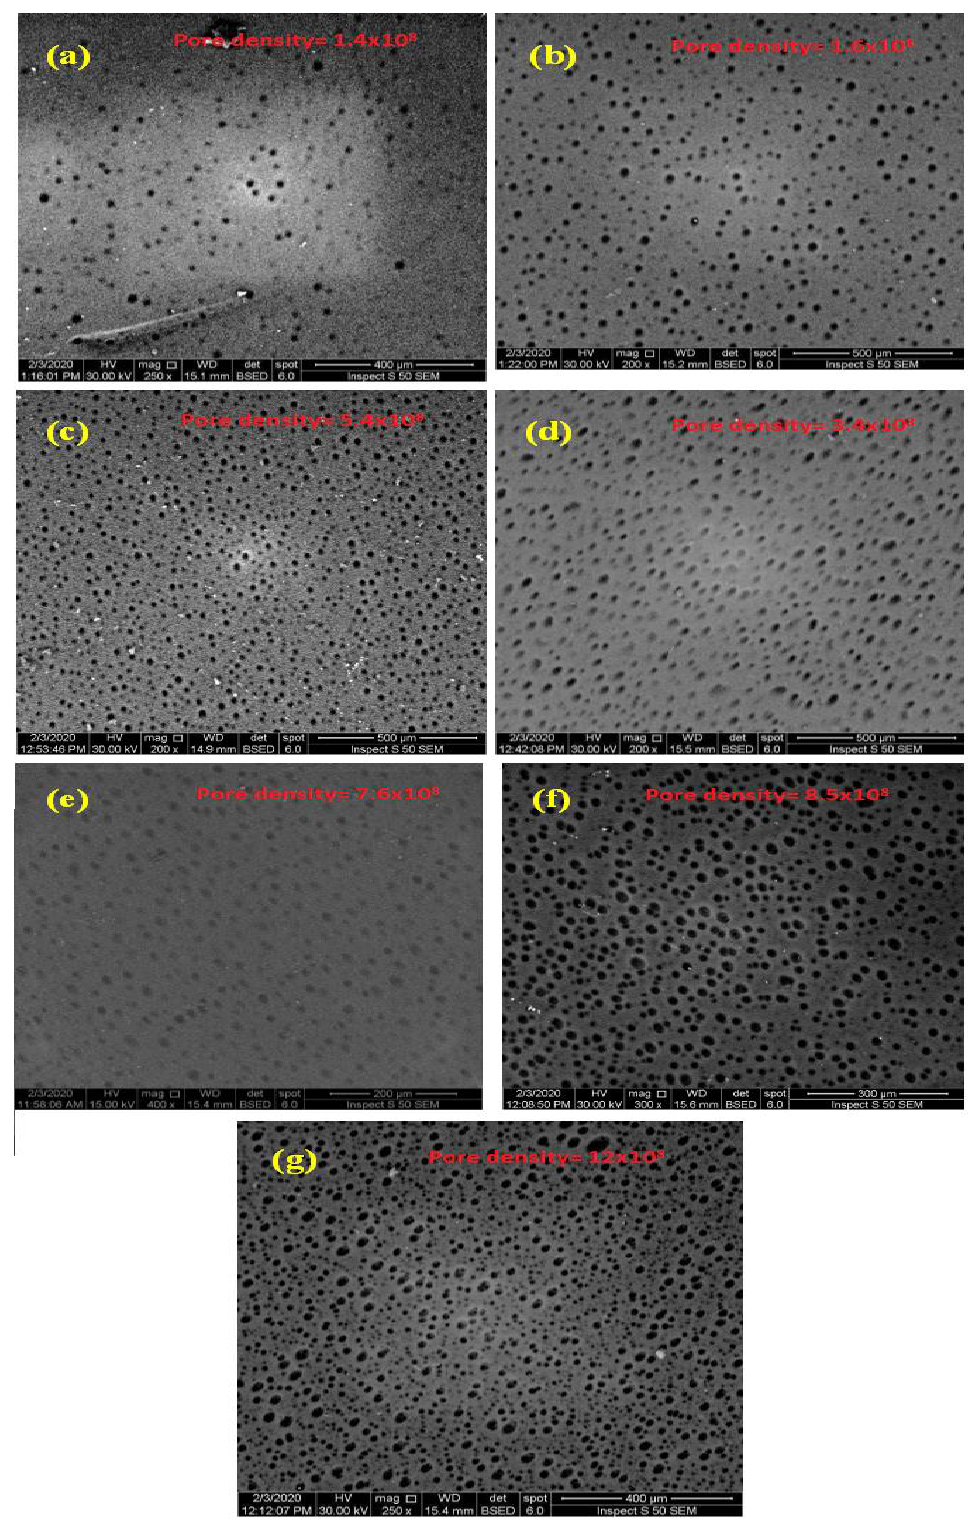
Figure 4. Top surface structures SEM images of ( a ) PES, ( b ) PES/PTGM (1 wt.%), ( c ) PES/PTGM (3 wt.%), ( d ) PES/PTGM (5 wt.%), ( e ) PES/PTGM (7 wt.%), ( f ) PES/PTGM (9 wt.%), and ( g ) PES/PTGM (11 wt.%) membranes.